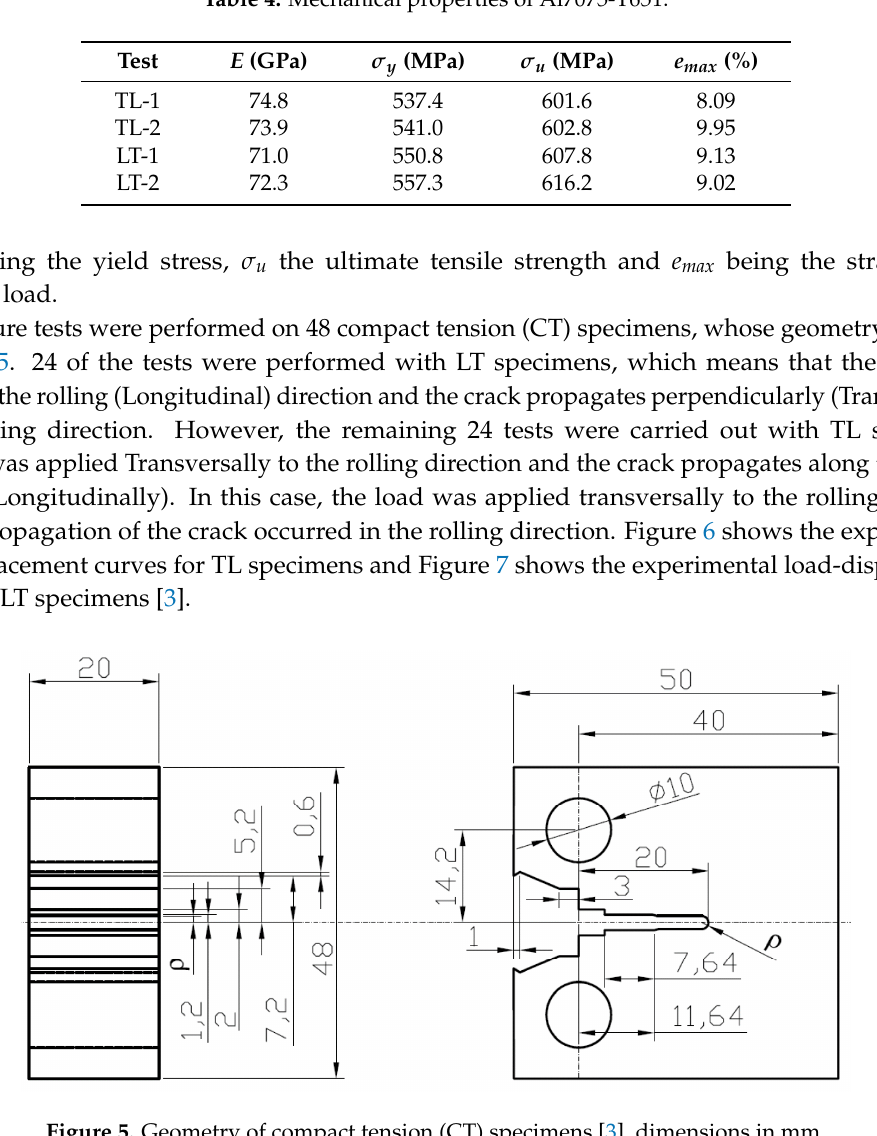
Table 5. Experimental fracture loads for TL and LT specimens. Reproduced with permission from